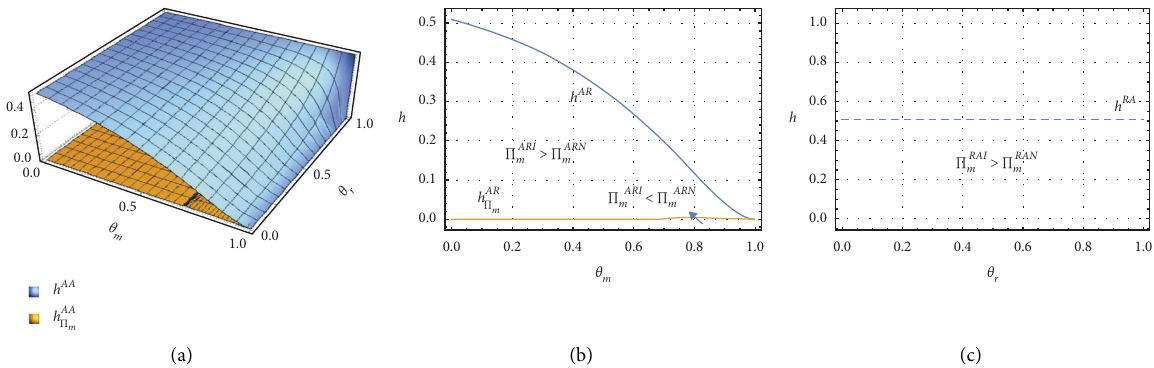
Figure 5: Tresholds of the manufacturer’s profts for diferent altruistic scenarios ( a � 1 ,b � 0 . 5 , c � 0 . 2 , c � 1 ) . (a) Both members are altruistic. (b) Only the manufacturer is altruistic. (c) Only the retailer is altruistic.